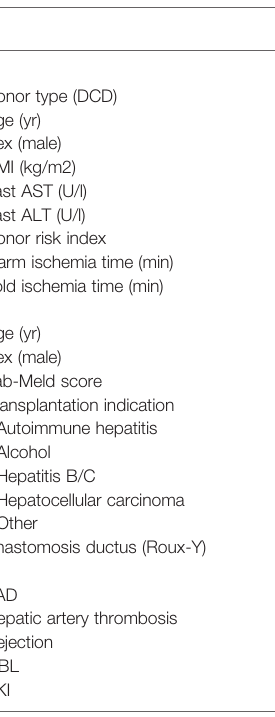
TABLE 1 | Donors and recipients characteristics of liver grafts with low pMLKL index versus high pMLKL